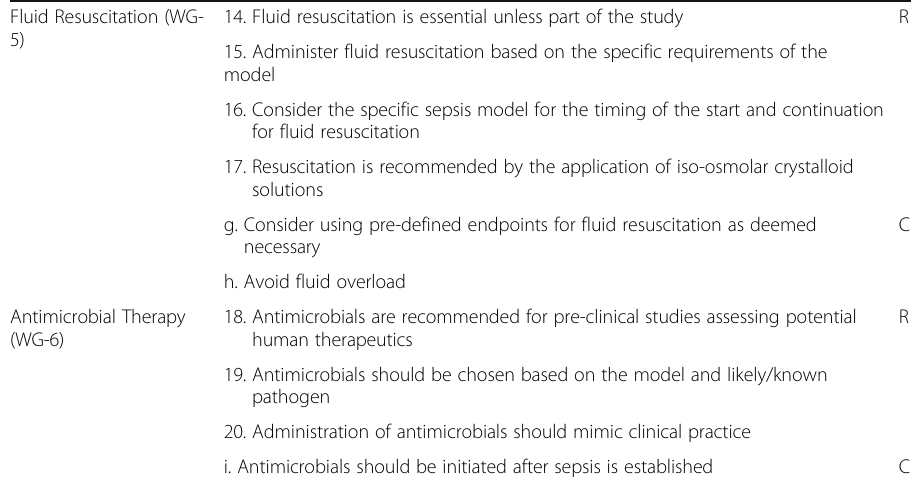
Table 3 Combined recommendations and considerations from the working groups (WG) 5 and 6 Fluid Resuscitation (WG-